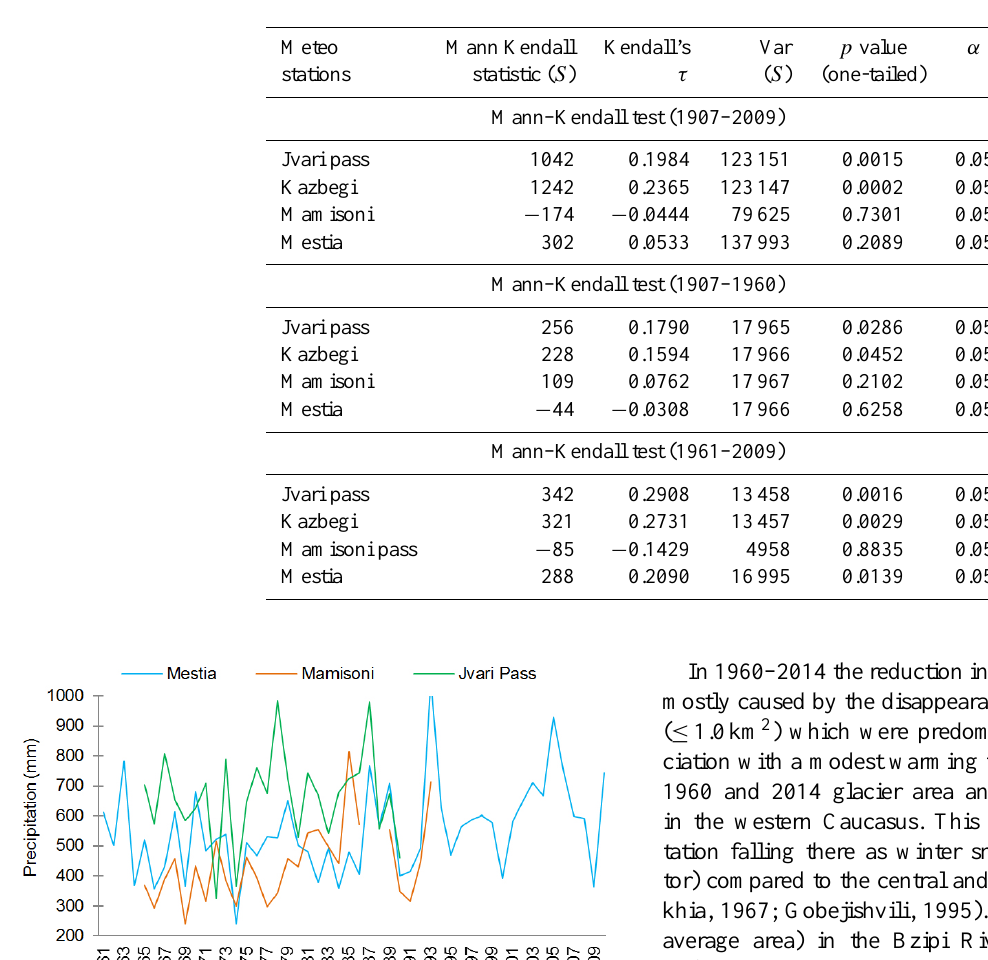
Figure 5. Mean annual air temperatures at the Mestia, Mamisoni, Jvari Pass and Kazbegi meteorological stations over the last century. The black line is the trend showing a temperature course with time. Table 4. Results of the Mann–Kendall test for temperature data for the weather stations of Georgia in the years of (1907–2009)–(1907– 1960)–(1961–2009). Statistically significant results are in bold.